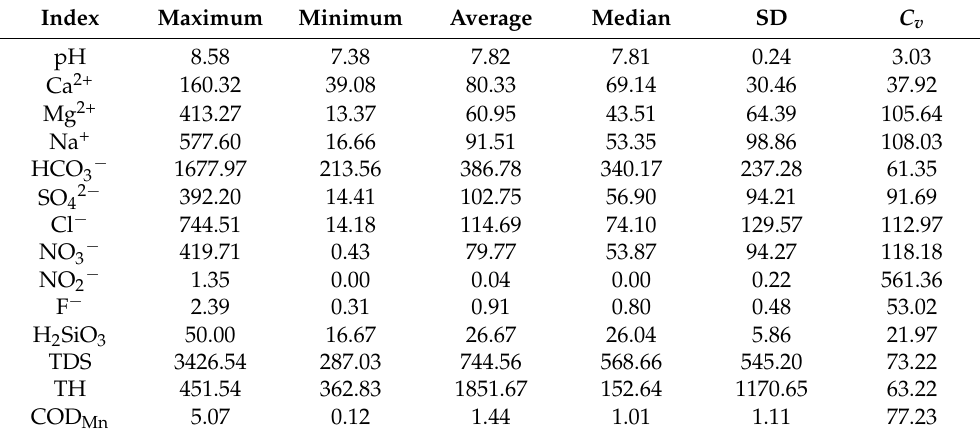
Table 3. Statistics of hydrochemical parameters of groundwater (n =